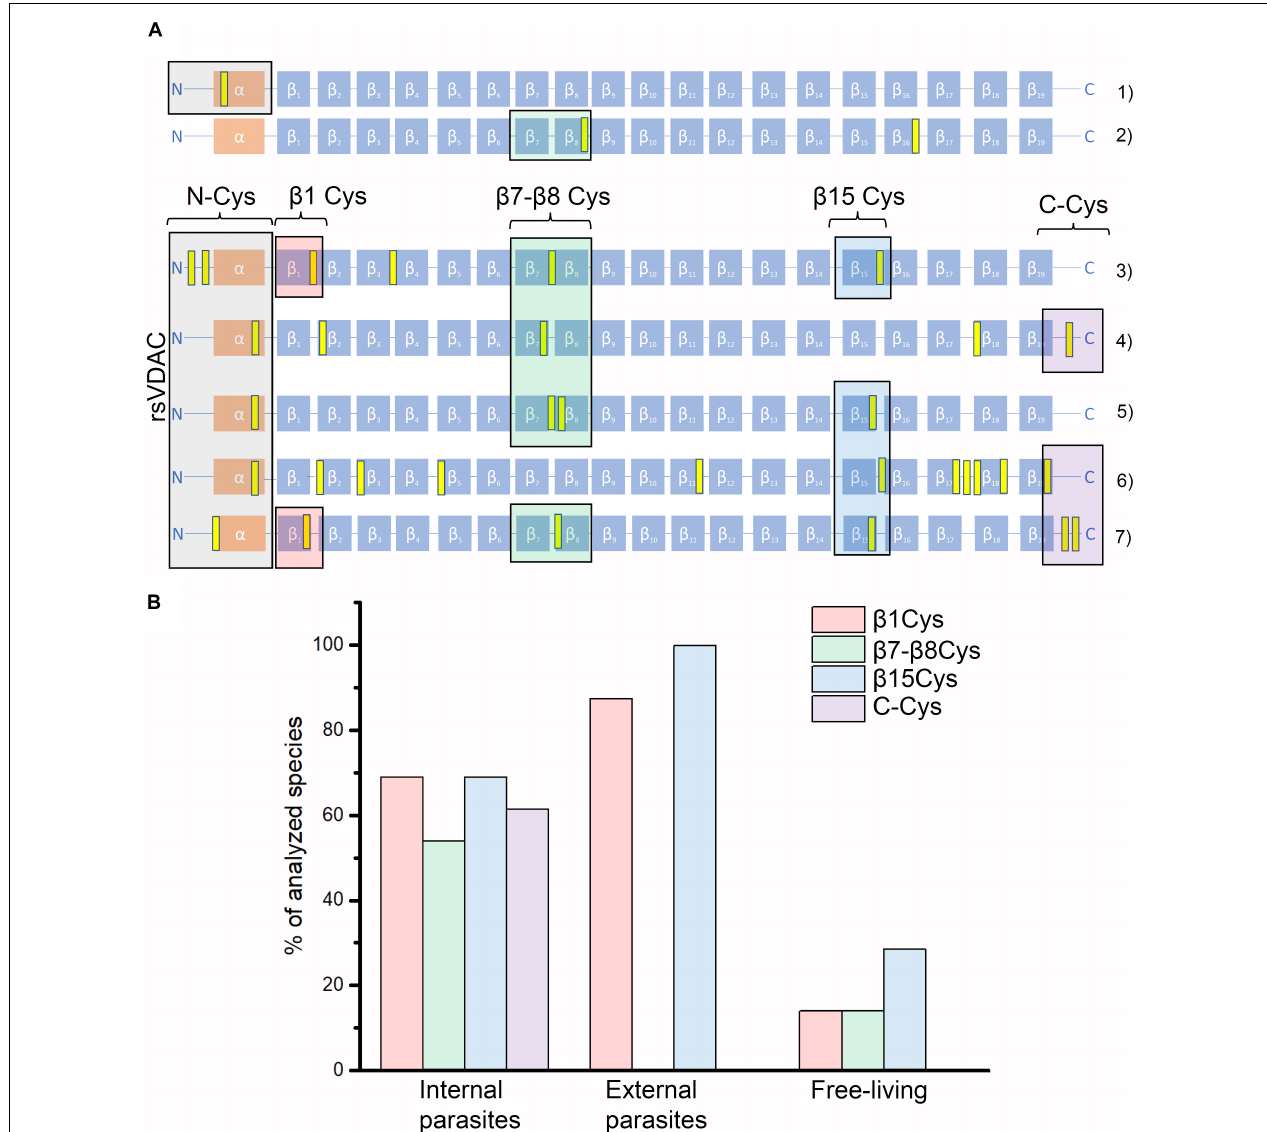
FIGURE 5 | VDAC variants that differ in their number and location of cysteine residues. (A) Graphical representations of the studied organisms’ VDAC secondary structure with indicated locations of cysteine residues (marked in yellow). They represent “redox-insensitive” VDAC (1–2) and redox-sensitive VDAC (3–7). (1) Hypsibius dujardini (free-living); (2) human VDAC1; (3) human VDAC3; (4) Dmel\CG17140; (5) Aceria tosichella (free-living); (6) Folsomia candida (free-living); and (7) Onchocerca flexuosa (parasitic, internal). (B) The percentage of studied organisms with their assumed rsVDAC, being the only VDAC variant in mitochondria, including their lifestyle and the presence of cysteine residues in the selected regions of VDAC proteins (see also Table 1 ). Besides rsVDAC, A. tosichella and F. candida possess also “redox-insensitive”